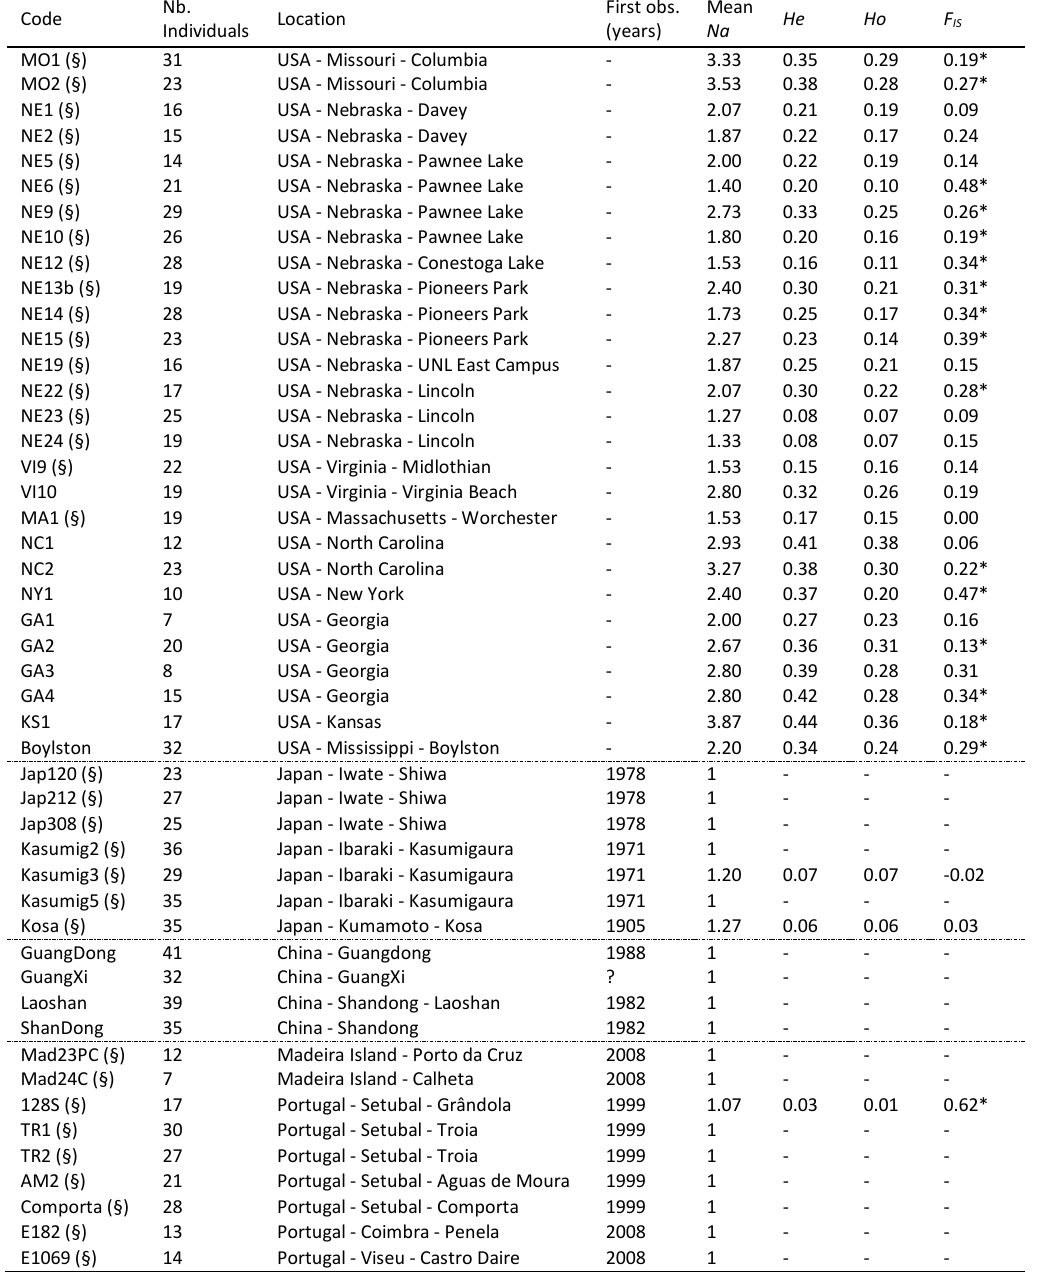
Table 1: Characteristics and population genetics summary statistics of the 48 site samples of the pinewood nematode used in this